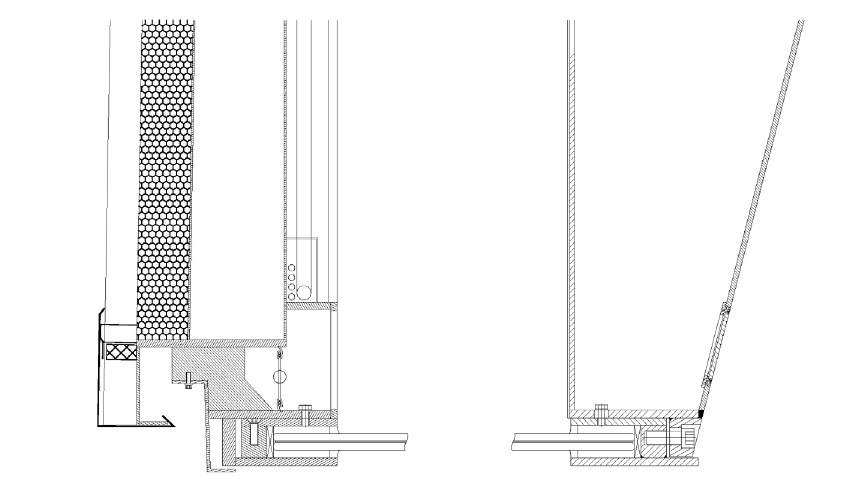
Figure 10: Clamping details at top and bottom.